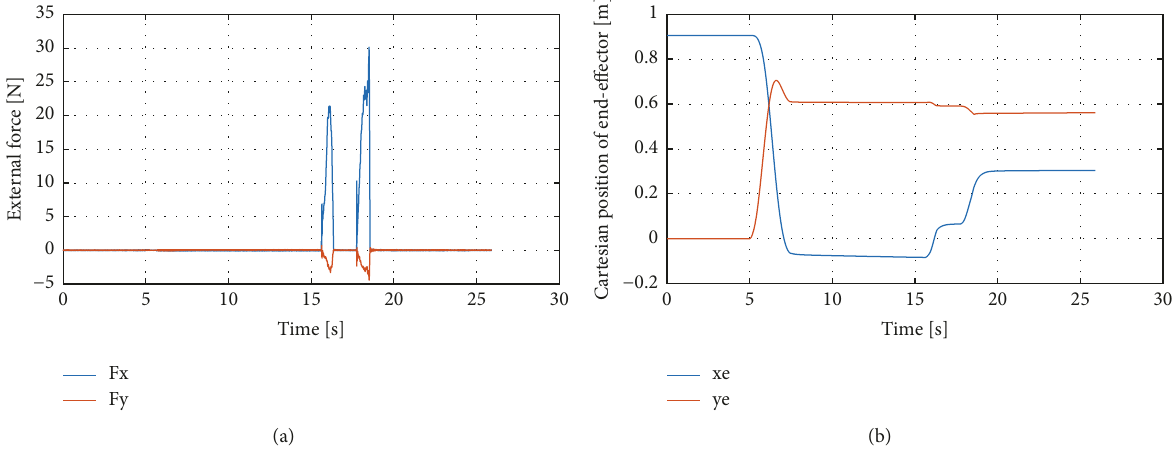
Figure 7: Experimental results of Maxwell model based Cartesian impedance control. (a) External forces. (b) End-effector position in Cartesian